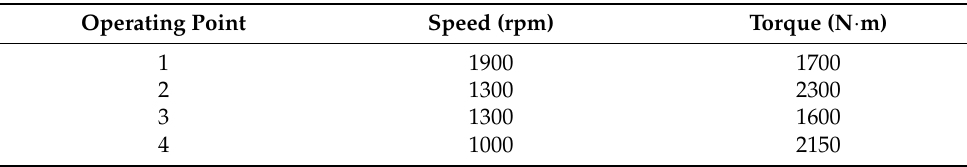
Table 5. Typical operating points selected for intake port